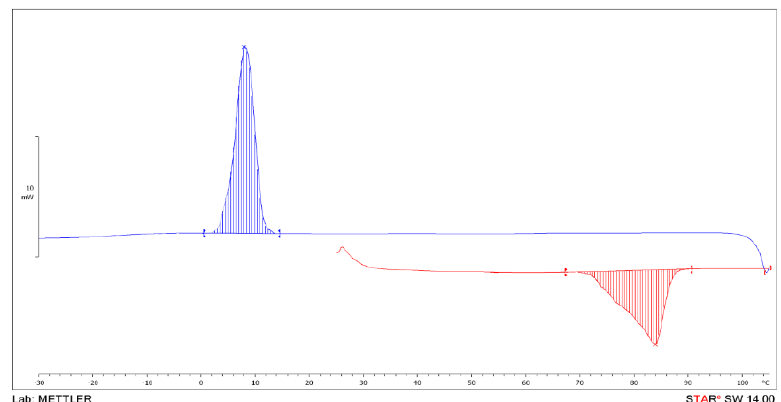
Figure 7. DSC thermogram of the decyl phenoxyethyl adipate.